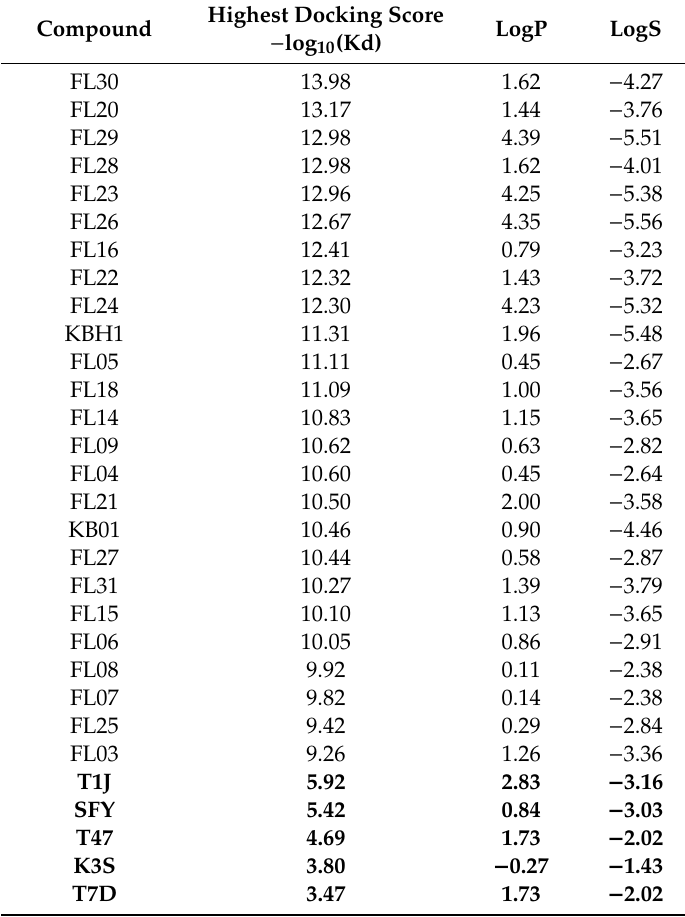
Table 8. Docking scores, LogP, and LogS values for optimized compounds and parent zinc database inhibitors.